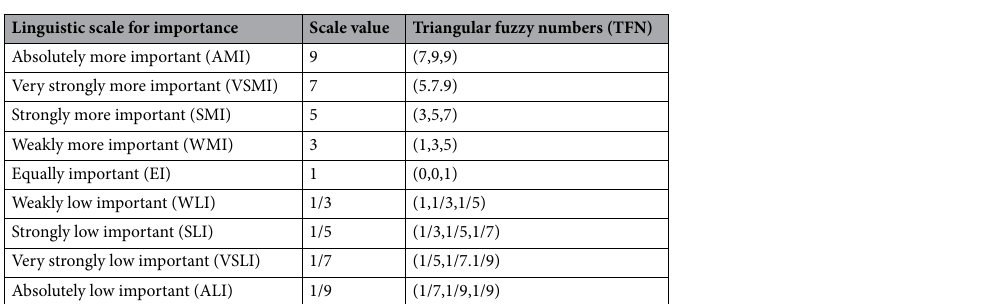
Figure 5. ( a ) The ranking result of CBA method; ( b ) The final result of CBA method when the costs in S1 change.